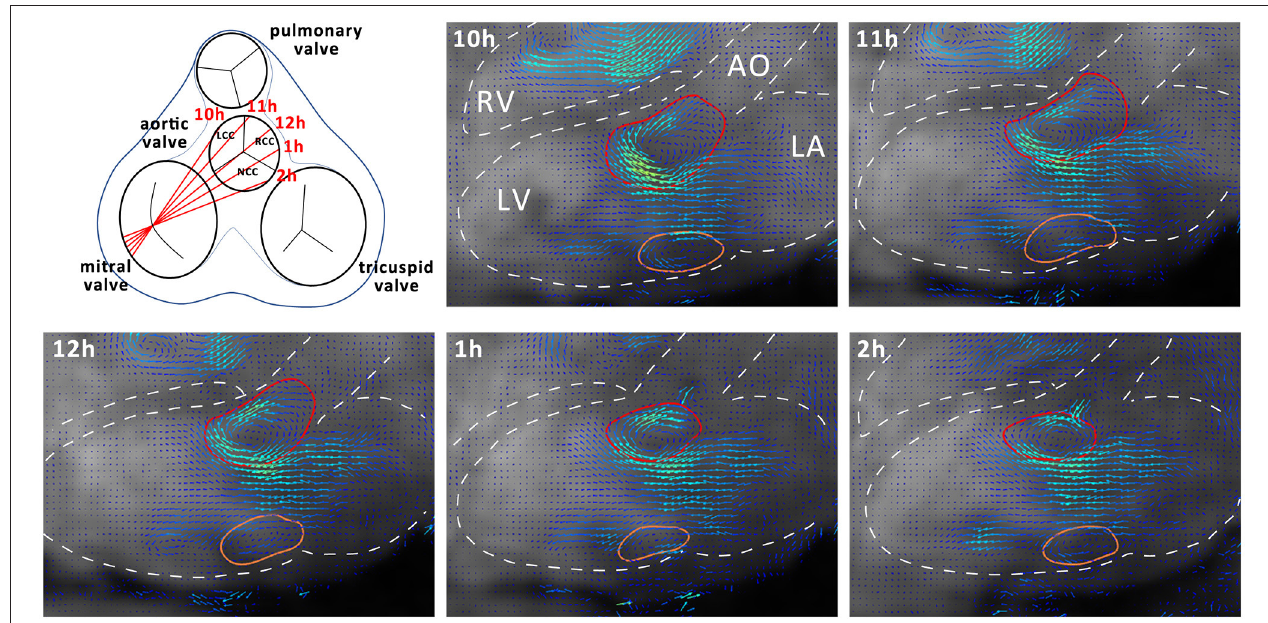
FIGURE 2 | Schematic representation of different observation planes annotated as 10–2h and example images for vortex cross sectional area estimation. Dashed white lines represent outline of anatomical structures of interest. AO, Aorta; LA, Left Atrium; LV, Left Ventricle; RV, Right Ventricle. Anterior cross section of the vortex is delineated in red and the posterior in